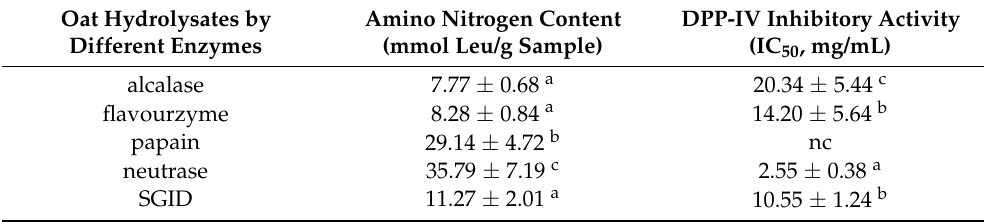
Table 1. Amino nitrogen contents and DPP-IV inhibitory activities of oat protein hydrolysates by different enzymes. The data marked by different letters for each determination are significantly different ( p <